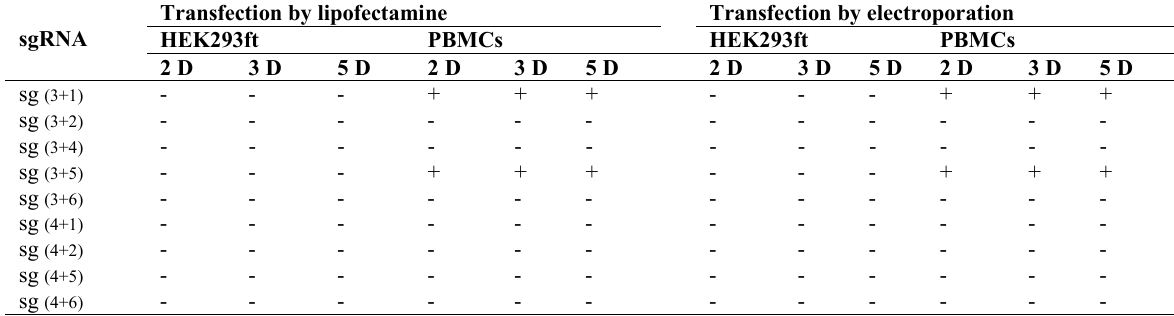
Table 3. Comparison of genome cleavage after lipofectamine and electroporation transfection in the different days.